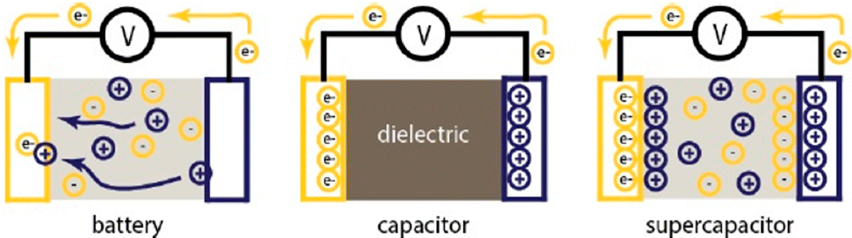
Figure 13. Schematics showing the differences in charge storage in a battery, a capacitor, and a supercapacitor. Reprinted with permission from the Springer Nature Customer Service Center GmbH [223].